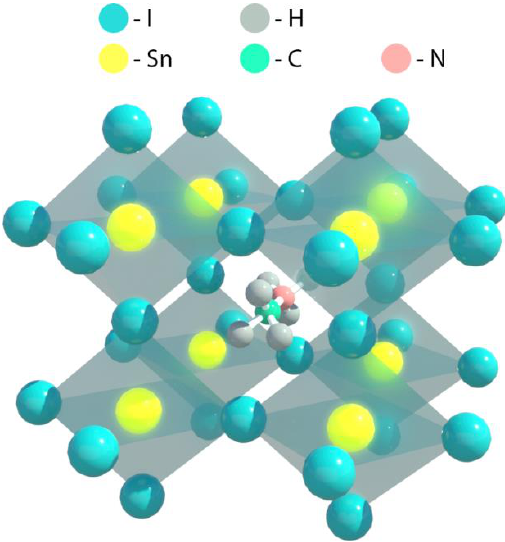
Figure 1. Unit cell of tin-based perovskite.